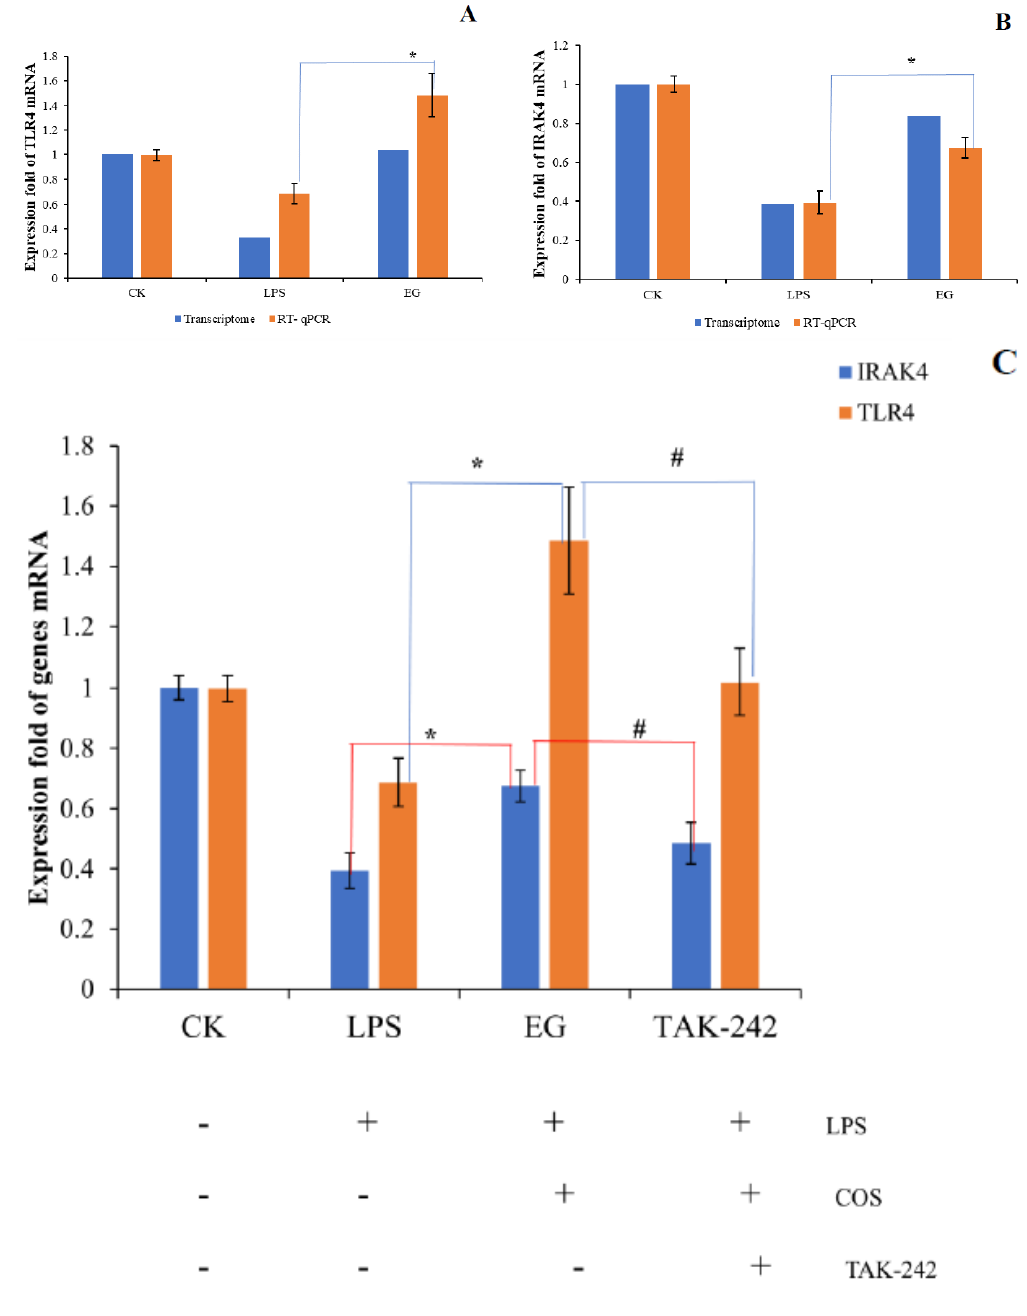
Figure 7. ( A ): Comparison between transcriptome and RT − qPCR of TLR4 in each group; ( B ): com- parison between transcriptome and RT − qPCR of IRAK4 in each group; ( C ): expression levels of TLR4 and IRAK4 when the EG group was treated with TLR4 inhibitor, TAK − 242. The * represents a significant difference compared with LPS group and # represents a significant difference compared with EG